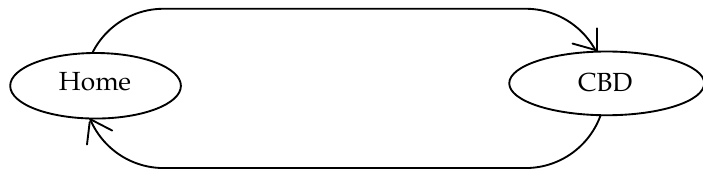
Figure 1. A bi-direction bottleneck